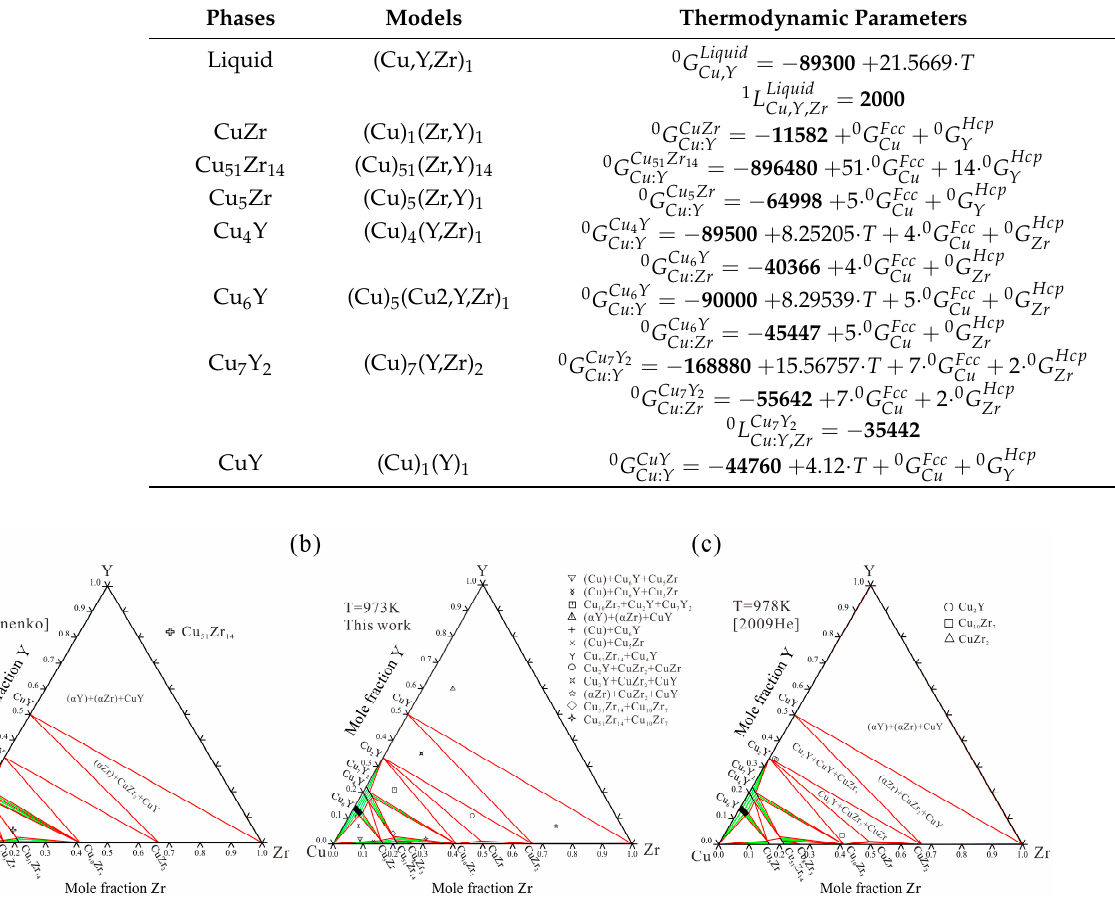
Figure 10. Calculated isothermal sections of Cu–Zr–Y system at ( a ) 870 K with experimental data [19], ( b ) 973 K with experimental data from this work and ( c ) 978 K with experimental data [18].